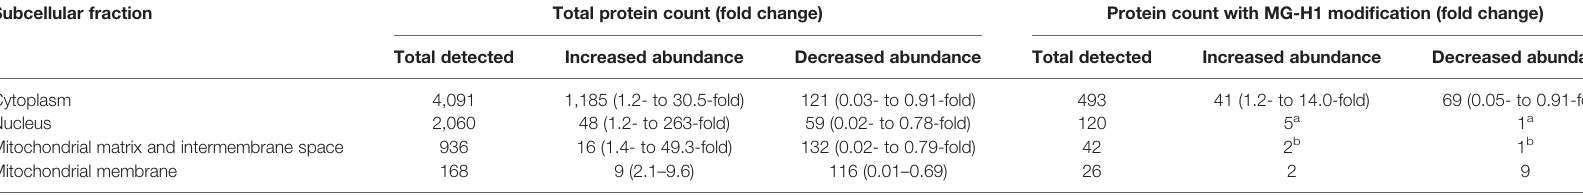
TABLE 2 | Subcellular fractional proteomics of HEK293 cells treated with methylglyoxal. Subcellular fraction Total protein count (fold change)